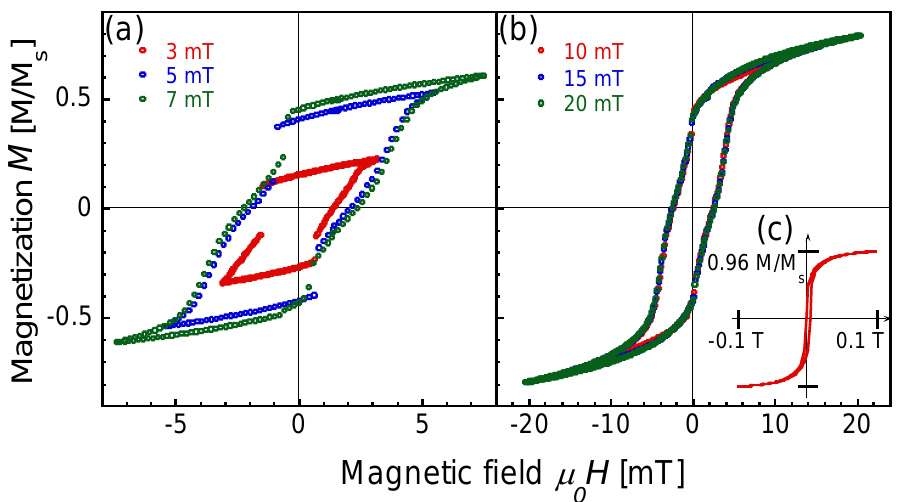
Figure 2. Magnetization curves of the Wiegand wire measured using a vibrating sample magnetome- ter. Minor loops traced under applied magnetic fields of ( a ) | H ap | = 3, 5, and 7 mT/ µ 0 ; ( b ) | H ap | = 10, 15, and 20 mT/ µ 0 ; and ( c ) a part of the full loop extracted in the field range of ± 0.1 T/ µ 0 traced under an applied magnetic field of | H ap | = 0.3 T/ µ 0 .